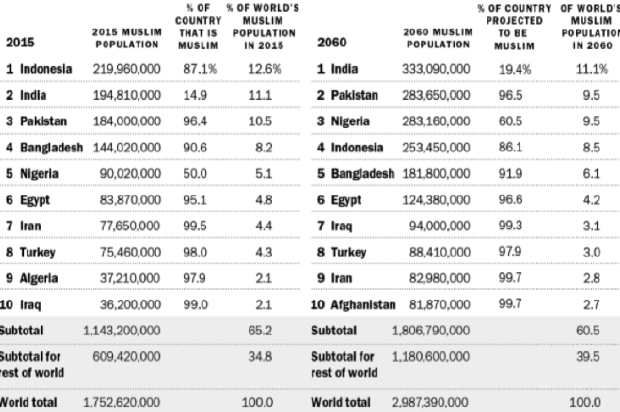
Source : Retrieved from PEW Resesarch Center in Diamant